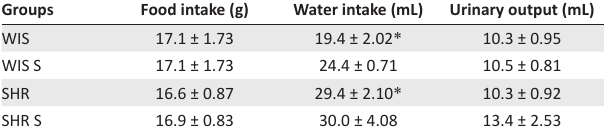
TABLE 4: Effect of multivitamin-multimineral supplementation on food, water intake and urinary output in spontaneously hypertensive and Wistar rats for week eight. Groups